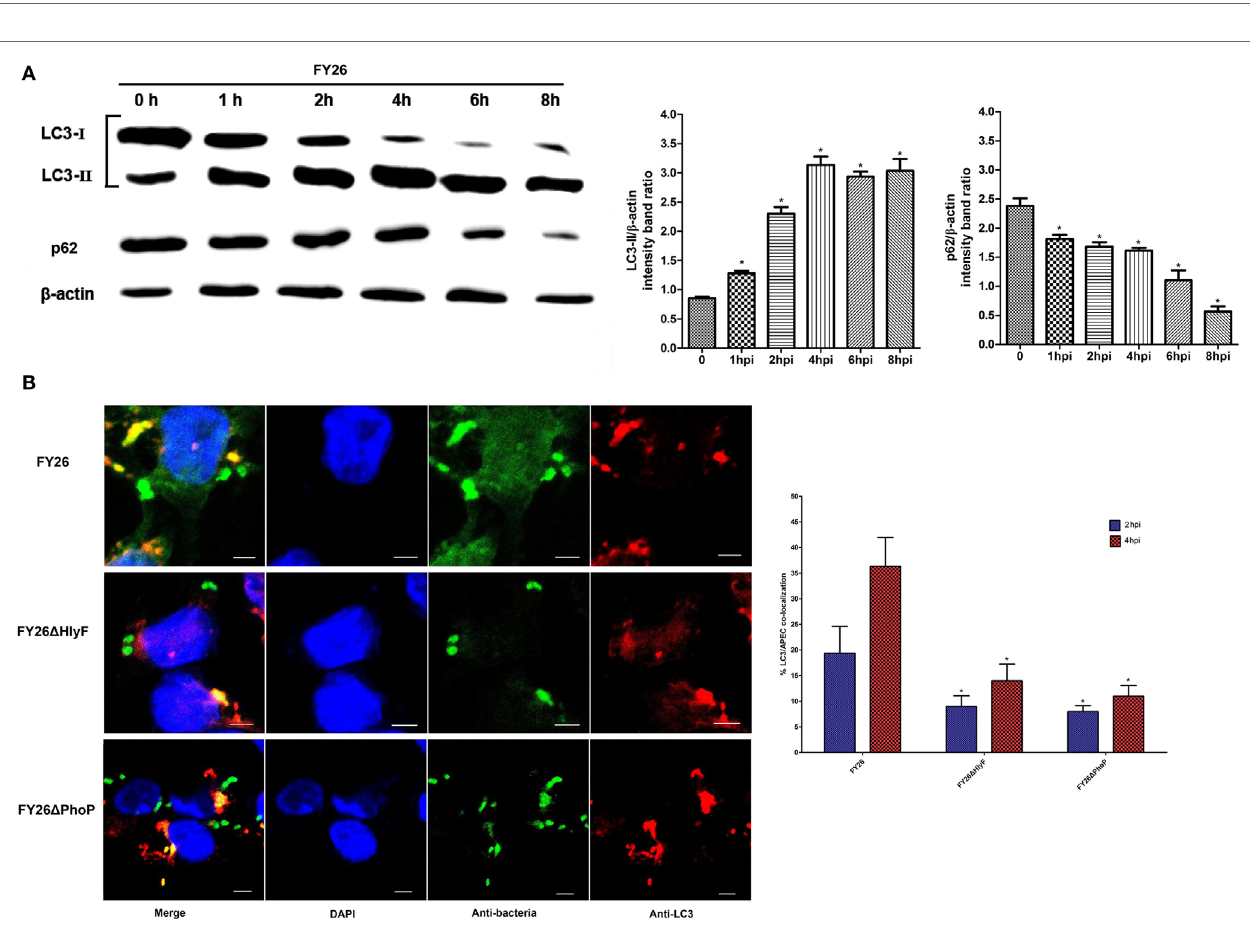
FigUre 5 | PhoP/PhoQ-HlyF pathway mediated extraintestinal pathogenic Escherichia coli (ExPEC) to prevent phagolysosomal fusion/acidification and damage the phagolysosomal membranes. (a) To determine the colocalization rates of LAMP1 with live or heat-killing (HK) wild-type FY26, FY26 Δ HlyF, and FY26 Δ PhoP at a multiplicity of infection (MOI) of 5. Bacteria were labeled with an anti-ExPEC antibody (Alexa 488, green) and anti-LAMP1 antibody (Alexa 568, red), and DNA was dyed with DAPI (blue). Representative confocal microscopy images [the left side of (a) ] for 2 hpi were shown. Scale bar = 10 µm. Quantification of the colocalization rates of ExPEC strains with LAMP1 at 2 and 4 hpi was shown in right side of (a) . (B) To determine the colocalization rates of acidotropic probe LysoTracker Red with wild-type FY26, FY26 Δ HlyF, and FY26 Δ PhoP at an MOI of 5. Bacteria were labeled with an anti-ExPEC antibody (Alexa 488, green) and LysoTracker Red (red), and DNA was dyed with DAPI (blue). Representative confocal microscopy images [the left side of (B) ] for 2 hpi were shown. Scale bar = 5 µm. Quantification of the colocalization rates of ExPEC strains with LysoTracker Red at 2 and 4 hpi was shown in right side of (B) . (c) To determine the colocalization rates of galectin 8 (Gal8) with wild-type FY26, FY26 Δ HlyF, and FY26 Δ PhoP at an MOI of 5. Bacteria were labeled with an anti-ExPEC antibody (Alexa 488, green) and anti-Gal8 antibody (Alexa 568, red). DNA was dyed with DAPI (blue). Representative confocal microscopy images [the left side of (c) ] for 2 hpi were shown. Scale bar = 5 µm. Quantification of the colocalization rates of ExPEC strains with Gal8 at 2 and 4 hpi was shown in right side of (c) . Data for quantification of the colocalization rates represented the results of more than 100 infected HD11 cells in at least three independent tests, and the mean values ± SEs were shown. The statistically significant differences were determined using one-way ANOVA analysis (* P <